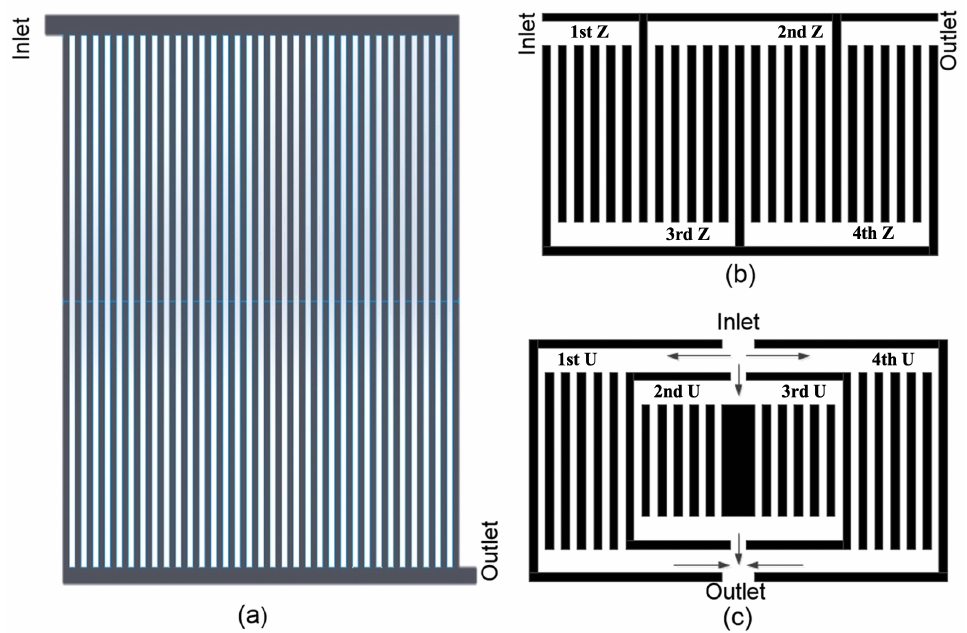
Figure 10. The geometry of the flow field: ( a ) conventional Z type; ( b ) multiple Z type; ( c ) optimized Z type